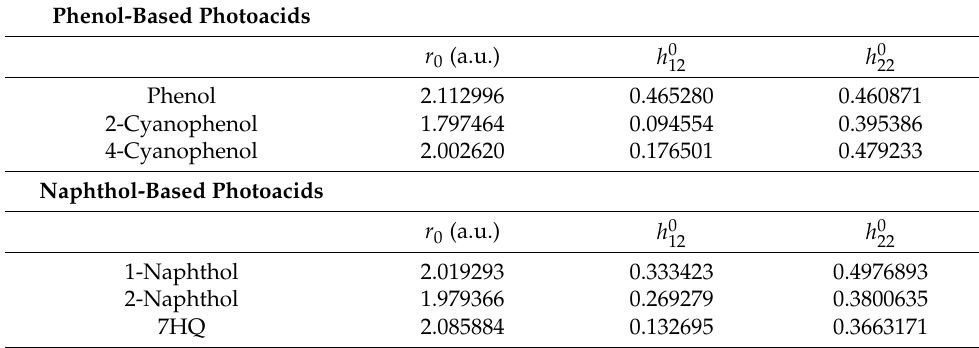
Table 1. Parameters for the acidic hydrogens (in atomic units) optimized for excited state proton transfer